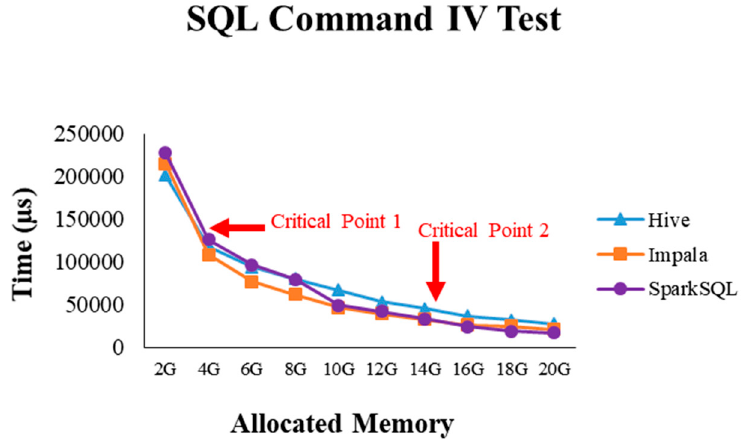
Figure 9. The average execution time of one record by SQL command III.